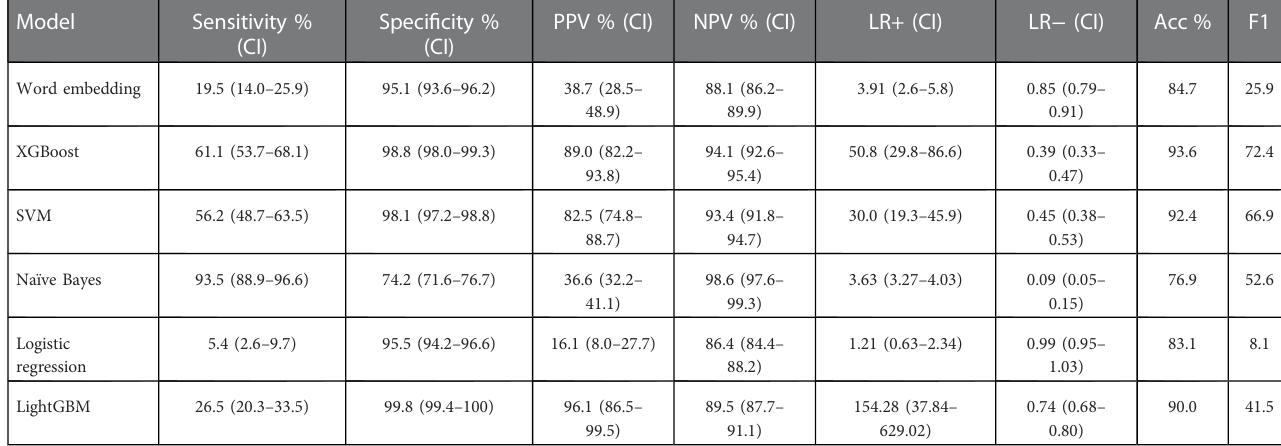
TABLE 4 Model characteristics of the validation cohort based on manual review by three content experts.